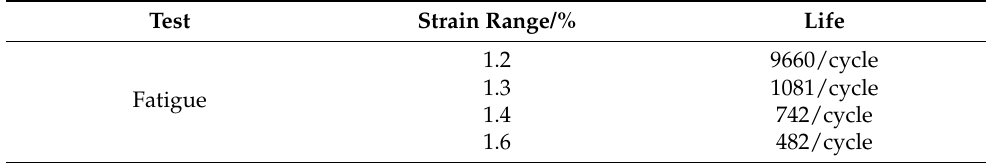
Figure 3. Fatigue experiments of Ti2AlNb alloy: ( a ) shape and dimensions of the LCF tests specimens; ( b ) fatigue loading waveform; and ( c ) evolution of maximum tensile stress per cycle [23]. Table 2. Fatigue life of four strain ranges [23].